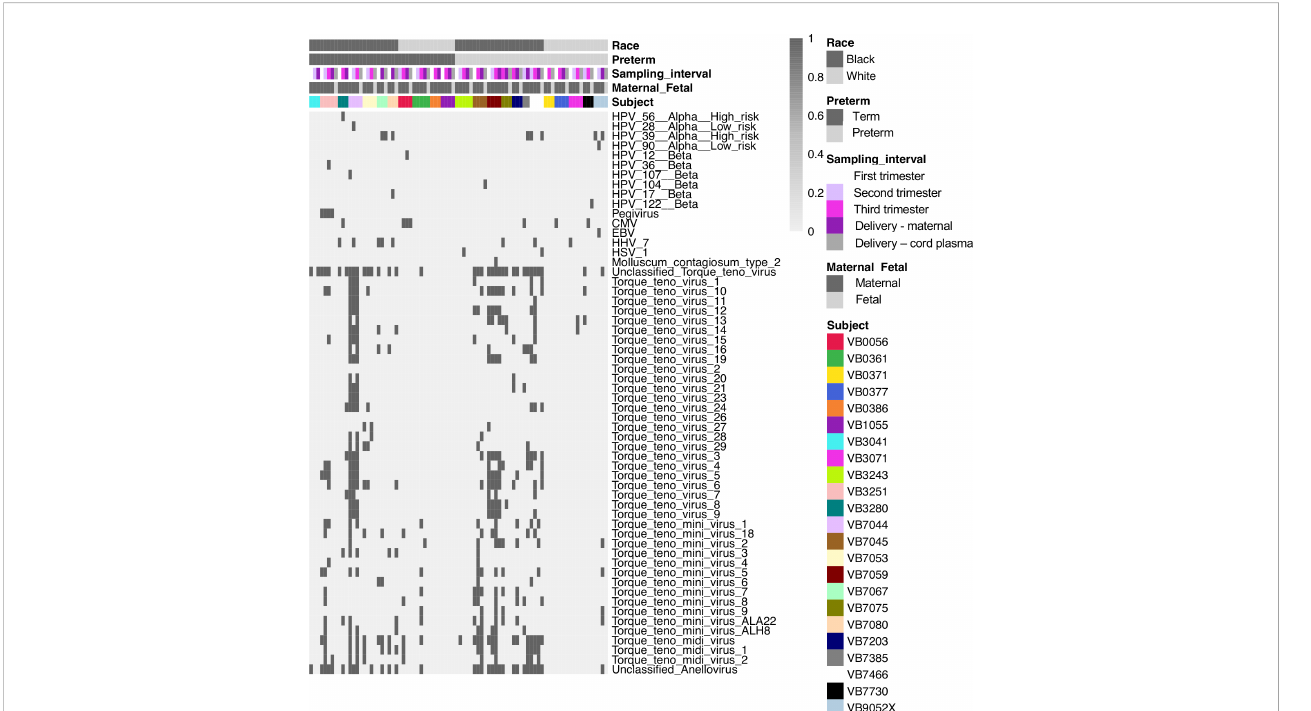
FIGURE 2 Viral types detected in maternal and cord plasma by metagenomic sequencing. Each column shows data from an individual sample from a subject. The top 5 rows indicate how samples are grouped based on race, preterm status, sampling interval (e.g. trimester of sampling or delivery), maternal or fetal sample, and subject. Each of the remaining rows represents data from an individual virus. A dark bar indicates the virus was detected in that sample.